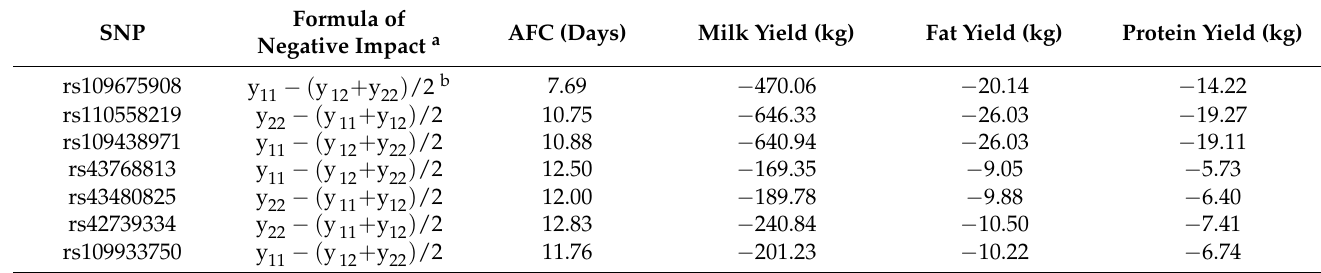
Table 3. Negative impact of recessive genotypes of seven SNPs on AFC and three yield